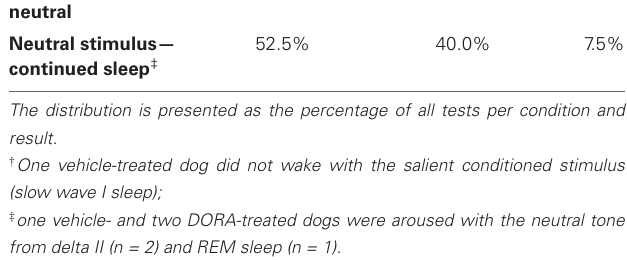
FIGURE 5 | Dogs awoke to the conditioned salient stimulus and slept through the neutral stimulus. Percentage of dogs ( n = 6–8) aroused into Active Wake during (A) unmedicated (20% Vitamin E TPGS vehicle) night sleep,